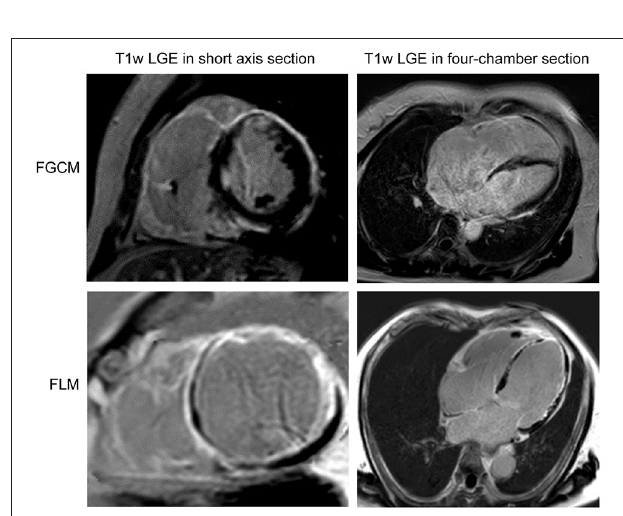
FIGURE 2 | Short axis (left column) and four-chamber section (right column) cardiac magnetic resonance images of representative patients with FGCM (upper line) and FLM (lower